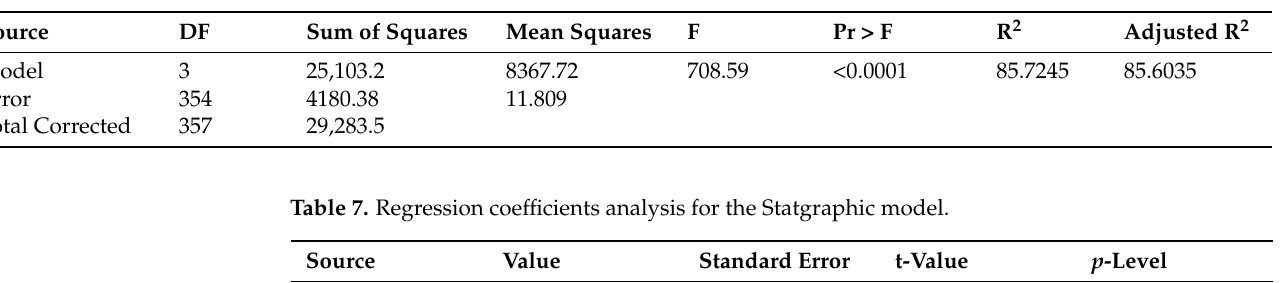
Table 6. Statistical evaluation of the Statgraphic model summary for the effluent WWQI.